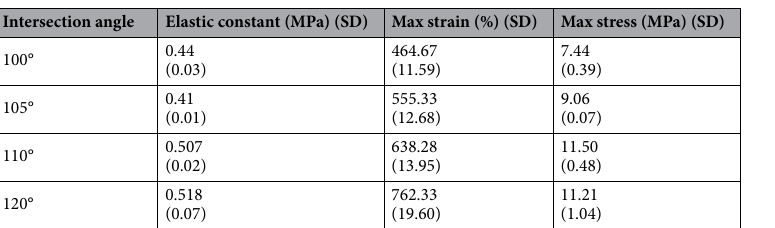
Figure 5. ( a ) Schematic of the fabrication process for the stretchable cylindrical textile interconnections from rotation of fibers around the core to embedding in silicone rubber and soldering edge parts for integration. ( b ) Photographs of stretchable cylindrical textile interconnection plane, cross section and twisted state and ( c ) stretching and recovery. ( d ) Relationship between strain and stress for the stretchable cylindrical textile interconnection depending on the intersection angle between fibers.